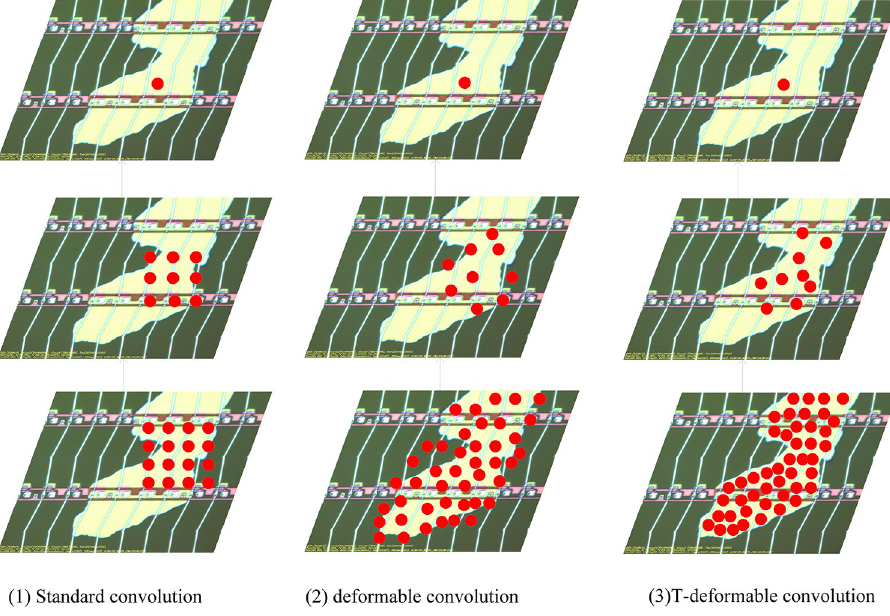
Fig 5. The difference between Standard convolution, deformable convolution, and T-deformable convolution. The left, middle, and right sides represent standard convolution, deformable convolution, and T-deformable convolution respectively. The upper, middle, and lower sides represent the activation unit on the feature map, 3 × 3 filter, sampling position.